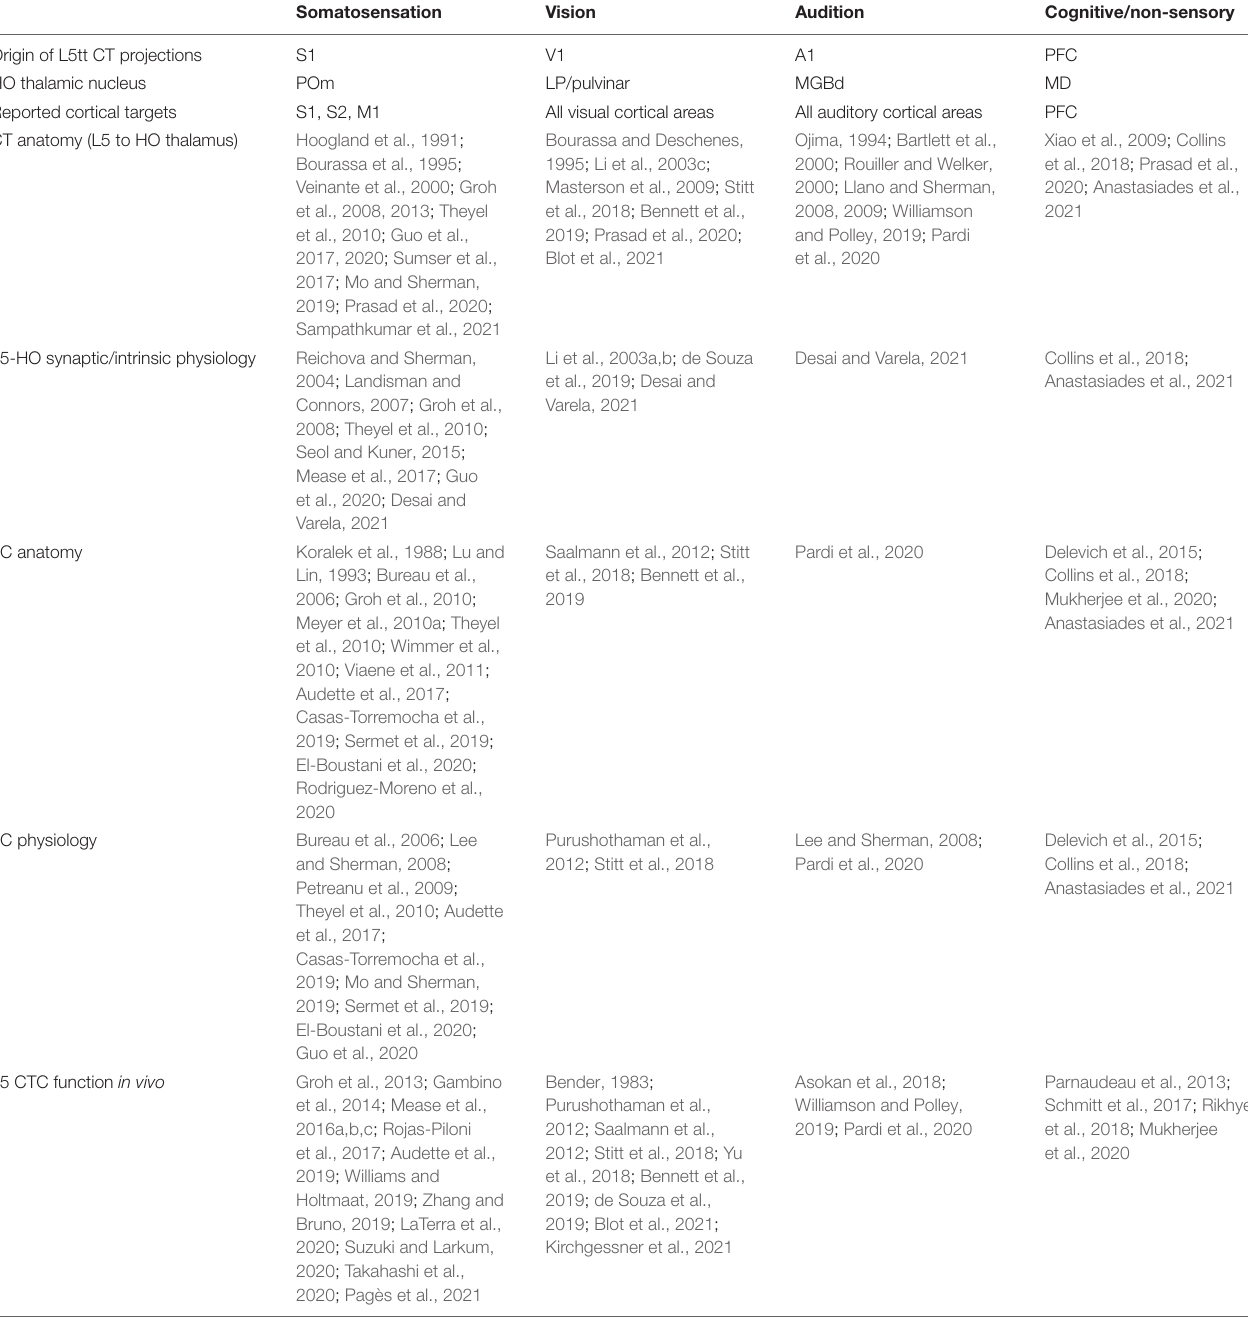
TABLE 1 | Key literature describing anatomical and/or physiological properties of CTC networks across sensory modalities and an example non-sensory